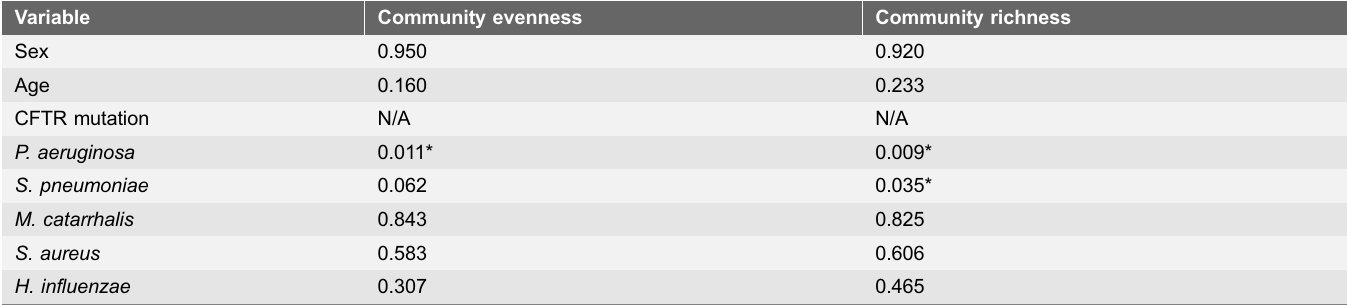
Table 3. Adonis scores for correlations between CF community diversity and discrete